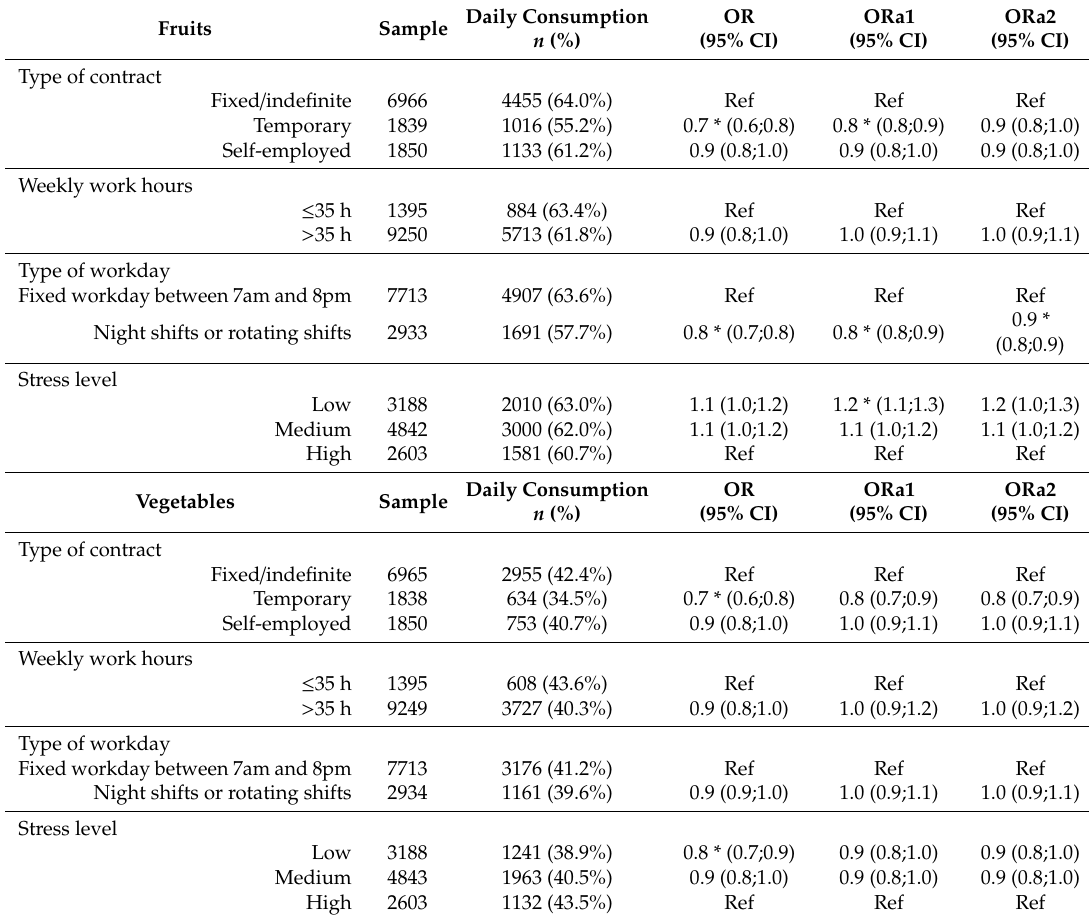
Table 2. Daily consumption of fruit and vegetables by work-related characteristics.